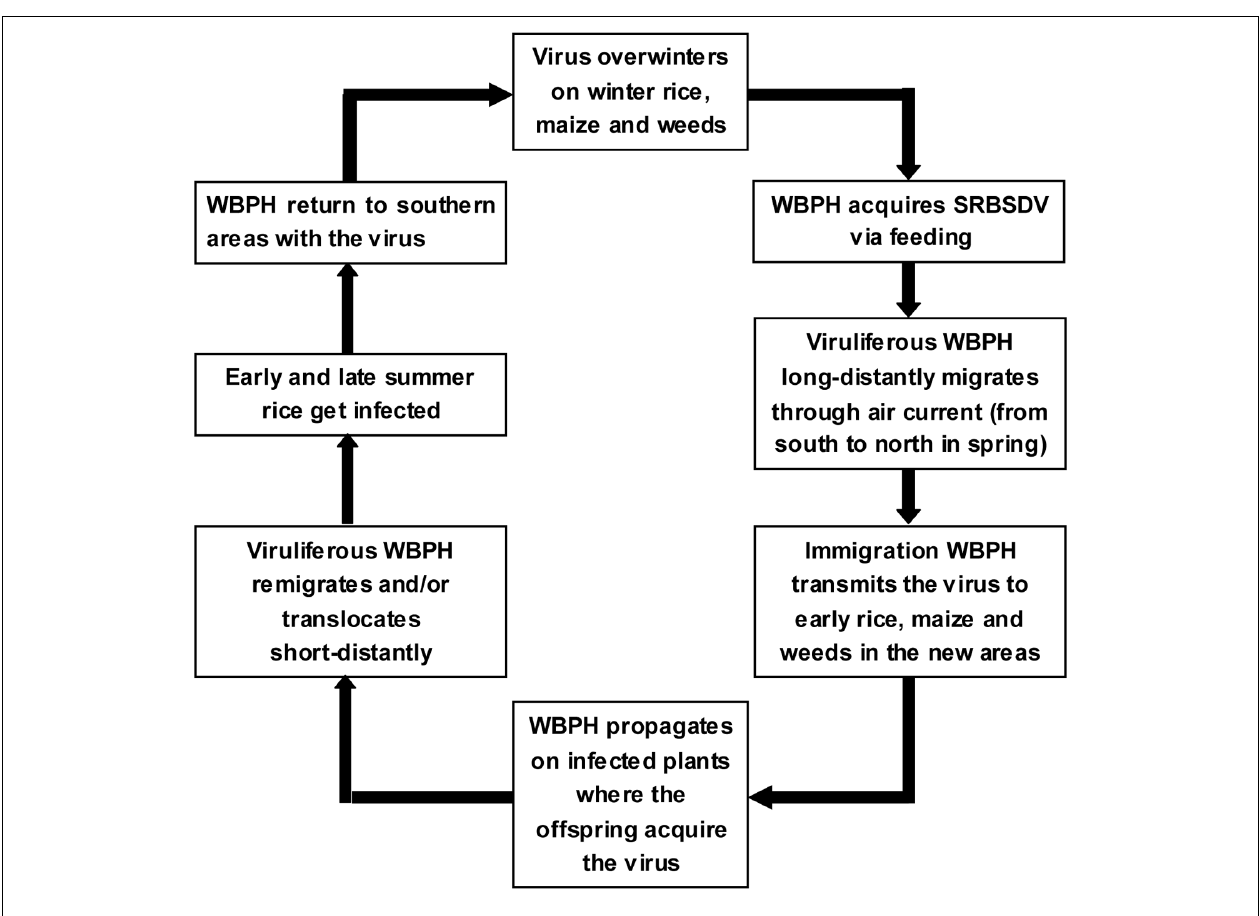
FIGURE 4 | Infection cycle of Southern rice black-streaked dwarf disease